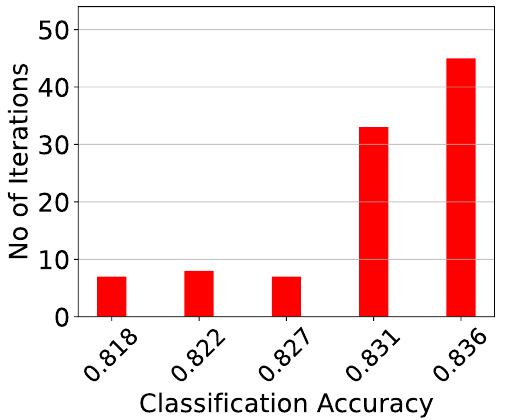
Figure 17. Post-layout Monte Carlo simulation results of the proposed architecture (for one of the previous 20